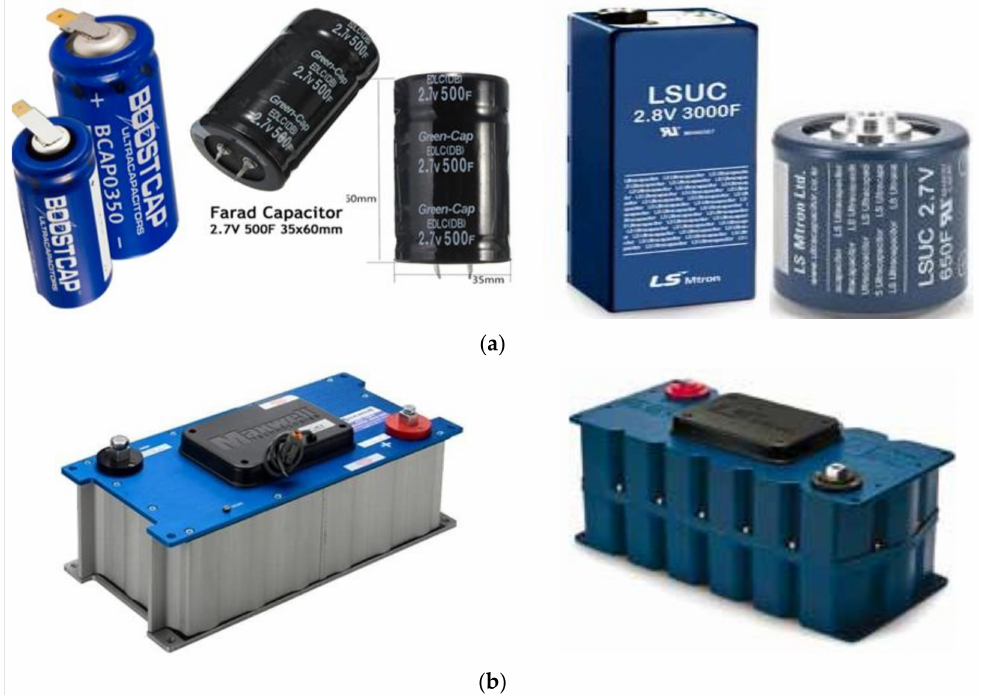
Figure 7. ( a ) Different types of SC commercial devices, ( b ) two different corporations’ SC